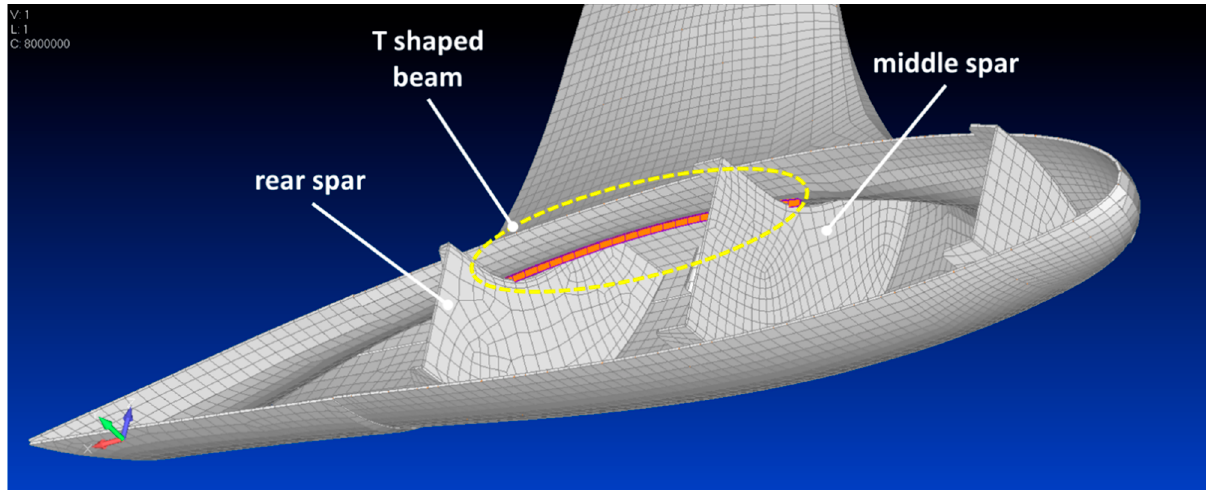
Figure 8. Layout of the chordwise beam to increase the rigidity on the critical zone.